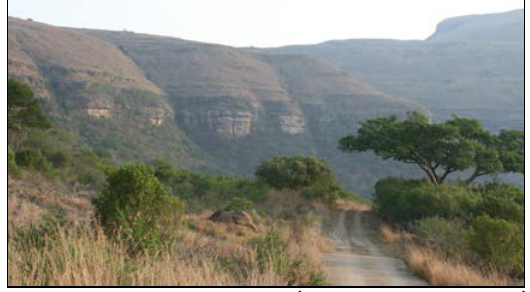
Figure 4: Ithala Game Reserve (Source M Jordaan, 2011)